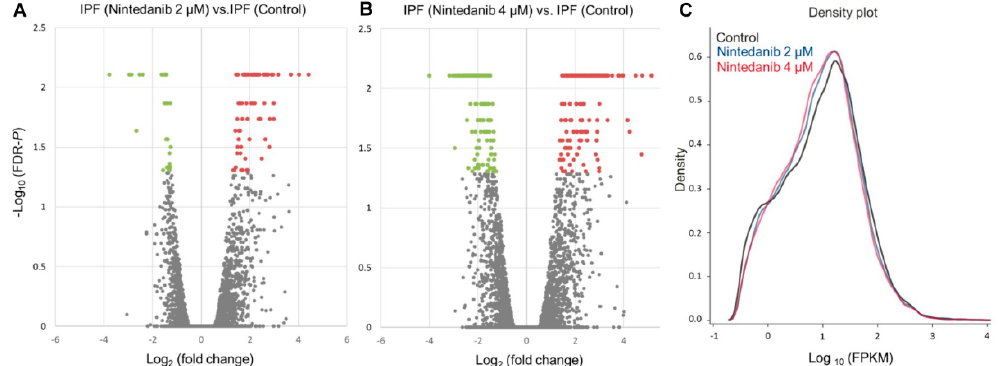
Figure 3. Display of gene expression data in nintedanib-treated IPF fibroblasts. ( A ) Volcano plots of differential gene expression patterns of IPF fibroblasts treated with 2 µ M nintedanib versus control. ( B ) Volcano plots of differential gene expression patterns of IPF fibroblasts treated with 4 µ M nintedanib versus control. Significantly dysregulated genes, i.e., − log 10 (FDR p ) > 1.3 and fold change >2, were shown in red (upregulation) and green (downregulation). ( C ) The density plots illustrate smoothed frequency distribution of the fragments per kilobase of transcript per million mapped reads (FPKM) among controls and IPF fibroblasts treated with 2 µ M and 4 µ M nintedanib.